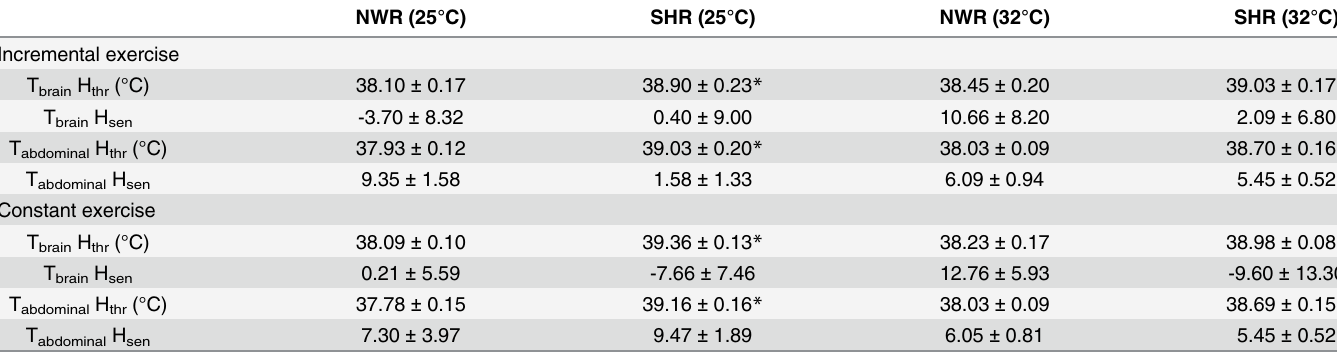
Table 3. Heat loss threshold and sensitivity during incremental or constant exercise in temperate or warm